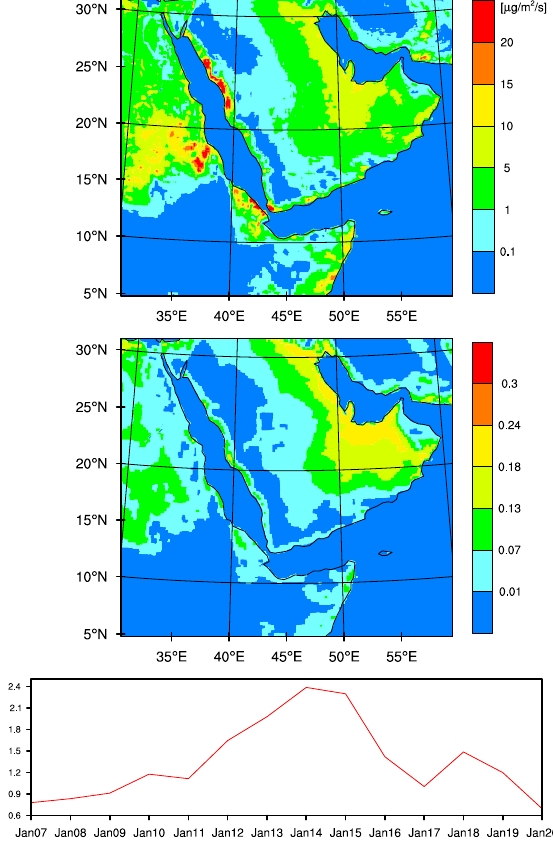
Fig. 3. Averaged for the simulation period of 7–20 January 2009 dust emissions [µgm − 2 s − 1 ] (top), source function (middle), and daily dust emissions [Tgday − 1 ]